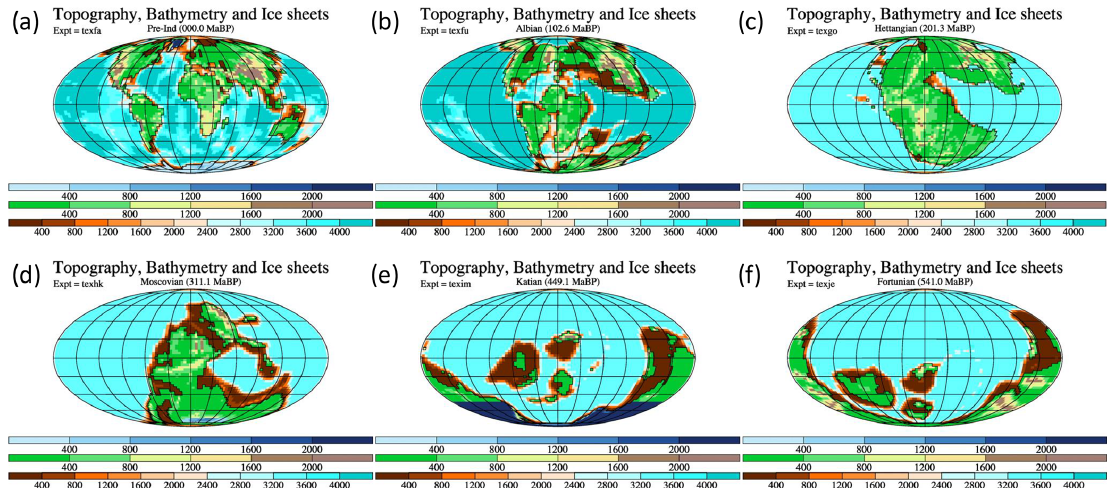
Figure 2. A few example paleogeographies, once they have been re-gridded onto the HadCM3L grid. The examples are for (a) present day, (b) Albian, 102.6Ma (Lower Cretaceous), (c) Hettangian, 201.3Ma (lower Jurassic), (d) Moscovian, 311.1Ma (Pennsylvanian, Carbonif- erous), (e) Katian, 449.1Ma (Upper Ordovician), and (f) Fortunian, 541.0Ma (Cambrian). The top colour legend refers to the height of the ice sheets (if they exist), the middle colour legend refers to heights on land (except ice), and the lower colour legend refers to the ocean bathymetry. All units are